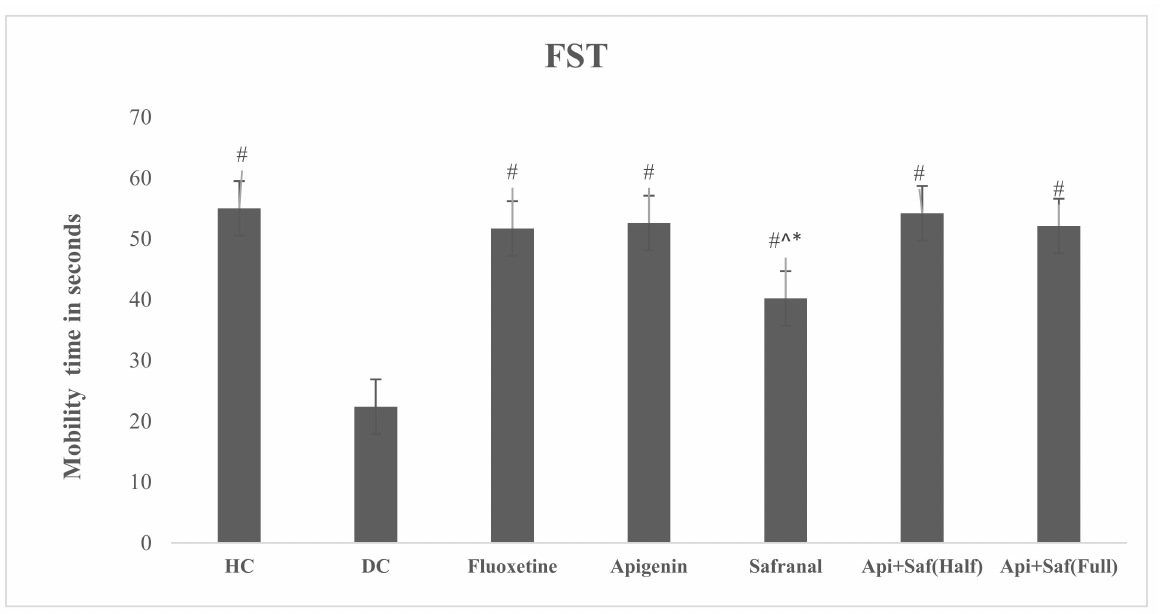
Figure 12. Effects of three weeks of oral (gavage) administration of safranal, apigenin, and its combination on FST in diabetic (induced) depressed rats. Values are shown as average ± SD (n = 10). One-way ANOVA was employed to analyze the results pursued by Tukey’s post hoc test. Here, # indicates significance ( p < 0.05) compared with diabetic control (DC), * indicates significance ( p < 0.05) compared with safranal and apigenin (half dose), and ˆ indicates significance ( p < 0.05) compared with safranal and apigenin (full dose). Key: healthy control (HC), diabetic control (DC), apigenin (Api), and safranal